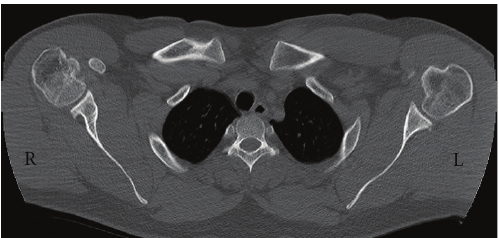
Figure 3: One-year follow-up axial CT scan view shows bilateral small defect (less than 25%) in anteromedial part of the humeral head. These defects are less than what was seen in Figure